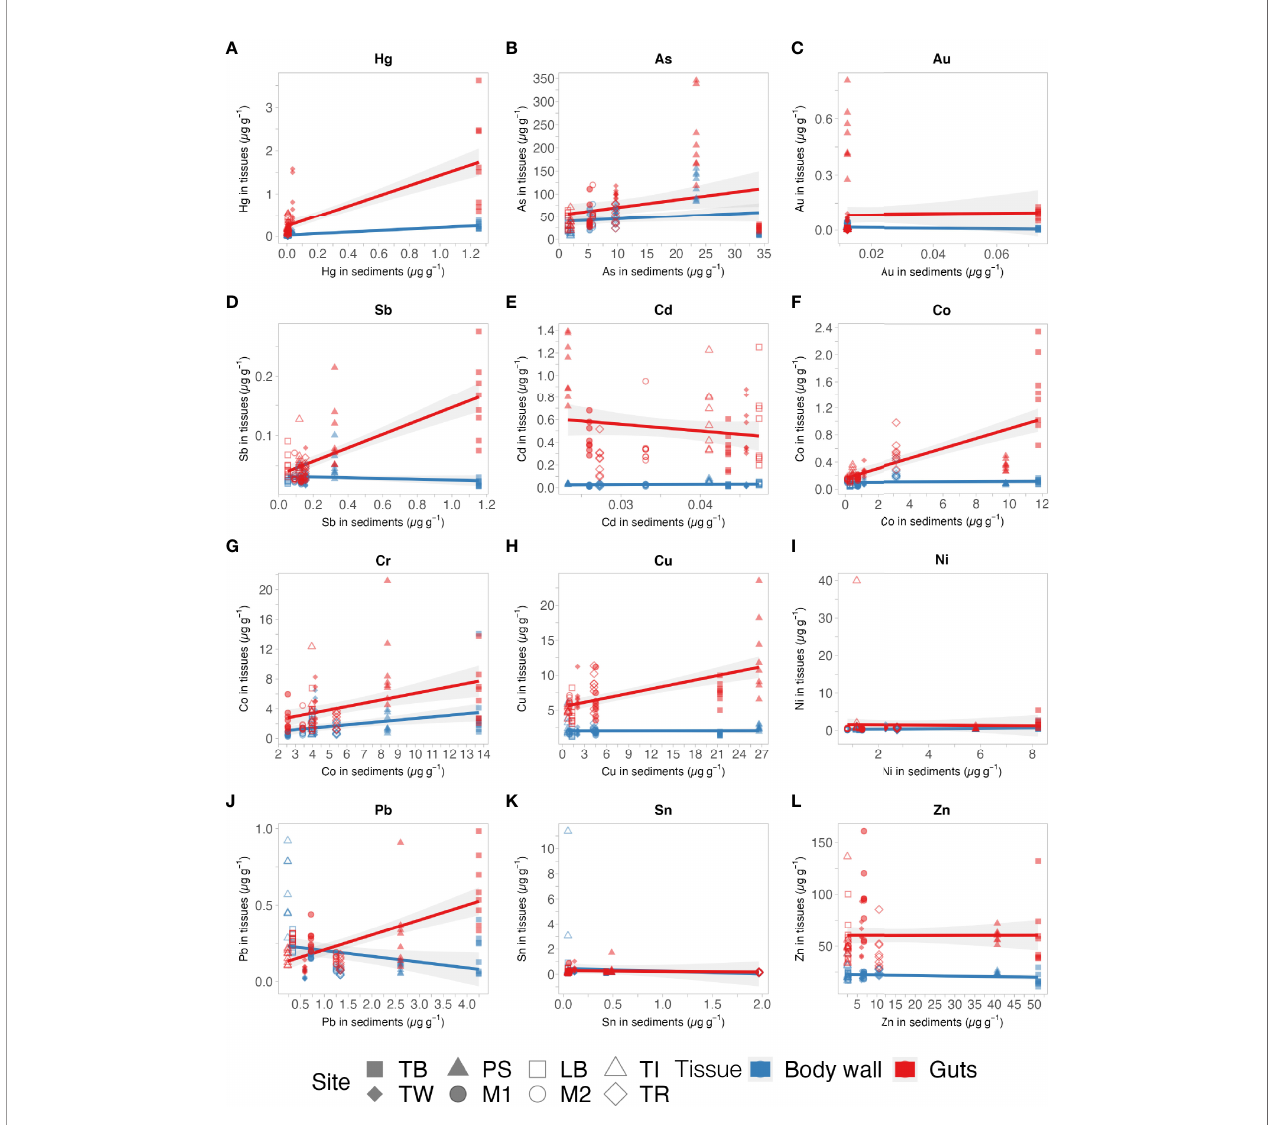
FIGURE 6 | Relations between the mean concentrations of Hg (A) , As (B) , Au (C) , Sb (D) , Cd (E) , Co (F) , Cr (G) , Cu (H) , Ni (I) , Pb (J) , Sn (K) and Zn (L) in sediments and their accumulation in holothurian tissues (blue: body wall, red: guts). Impact sites are represented by solid symbols (TB, Totok Bay; TW, Talawaan River; PS, Pantai Surabaya; M1, West Bangka mangroves), while control sites by open symbols (LB, Lihunu Bay; M2, North-west Bangka mangroves; TI, Tumbak Island; TR, Tasik Ria Resort). Lines indicate the linear tendencies, and the grey shadow areas the corresponding 95% con fi dence